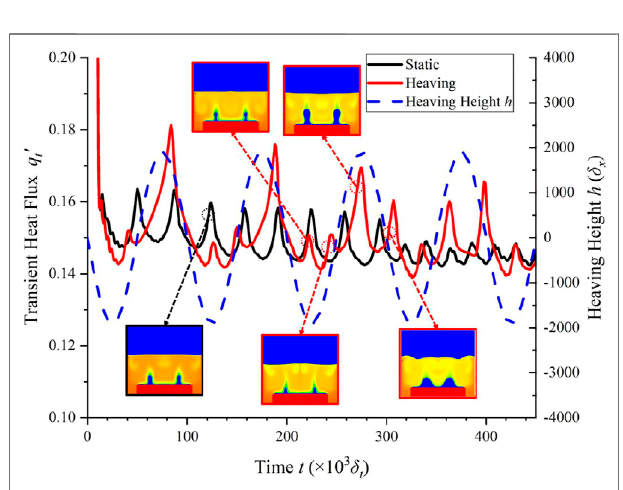
FIGURE 14 | Transient heat fl ux at the fi lm boiling regime with Ja (cid:1) 0.394.